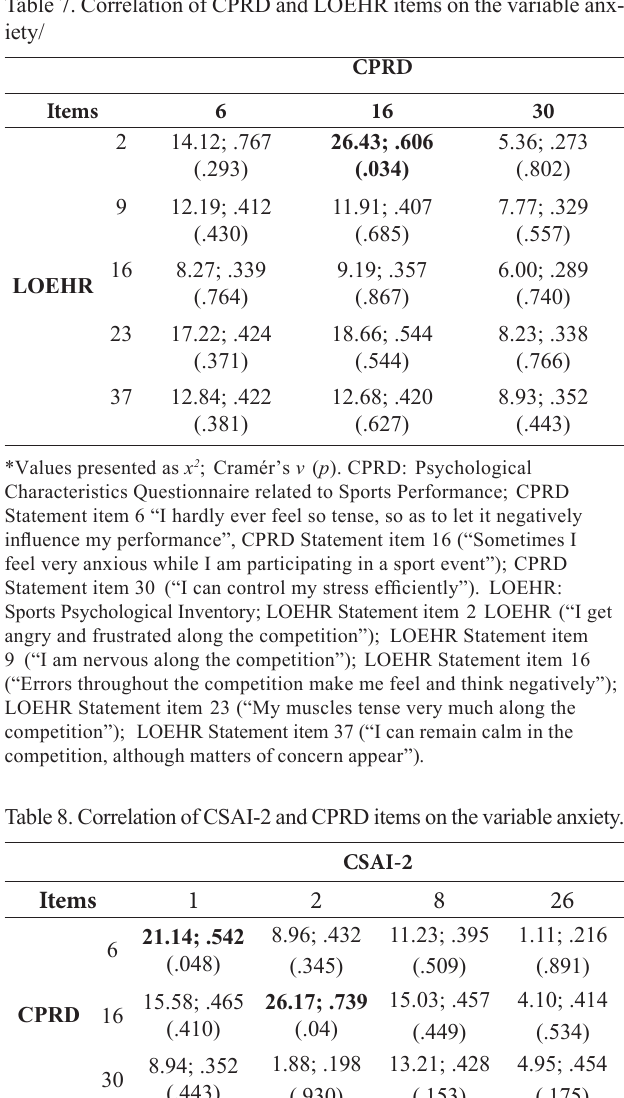
Table 7. Correlation of CPRD and LOEHR items on the variable anx- iety/ Items